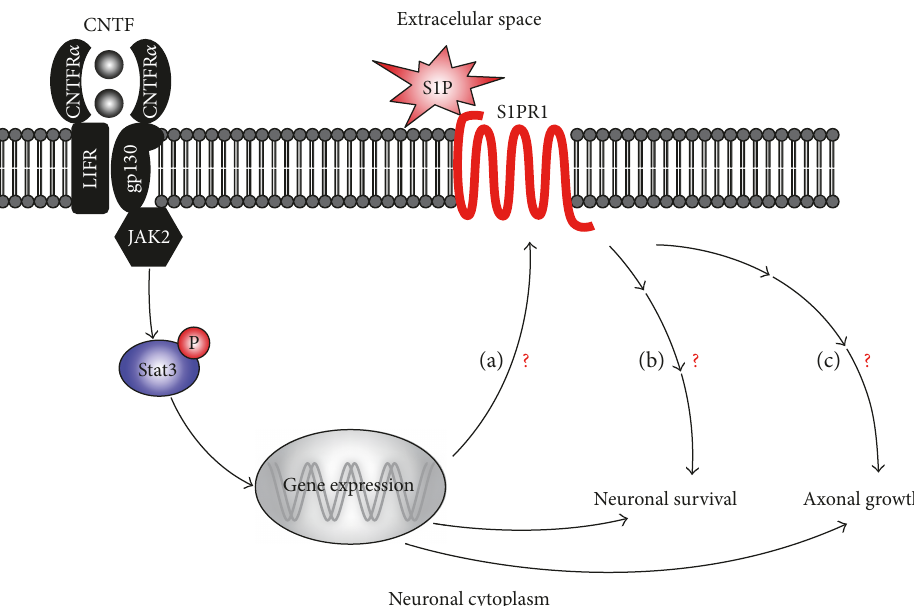
Figure 1: Hypothetical mechanism by which CNTF/Stat3 and S1P/S1PR1 interaction may orchestrate neuronal survival and axonal growth. CNTF binds and activates a heterotrimeric receptor complex, composed of CNTFR α , leukemia inhibitory factor receptor (LIFR), and gp130, leading to Stat3 phosphorylation (P-Stat3) and activation. (a) P-Stat3-driven transcription may increase the expression of S1PR1 and its translocation to the plasma membrane. The activation of S1PR1 by S1P may trigger downstream growth mechanisms resulting in (b) neuronal survival and (c) axonal